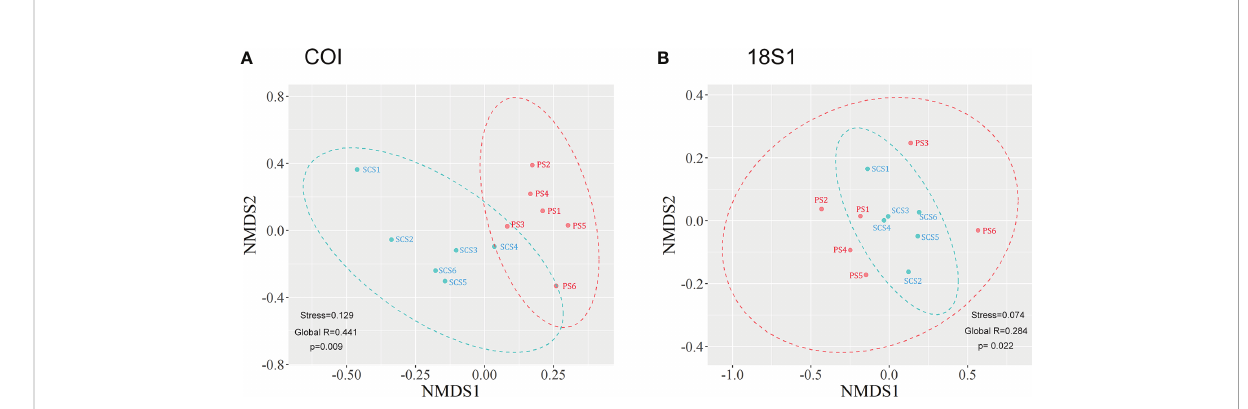
FIGURE 4 nMDS ordination of COI (A) and 18S1 (B) based on Bray-Curtis similarity. SCS sites are marked in cyan, while PS sites are marked in orange.